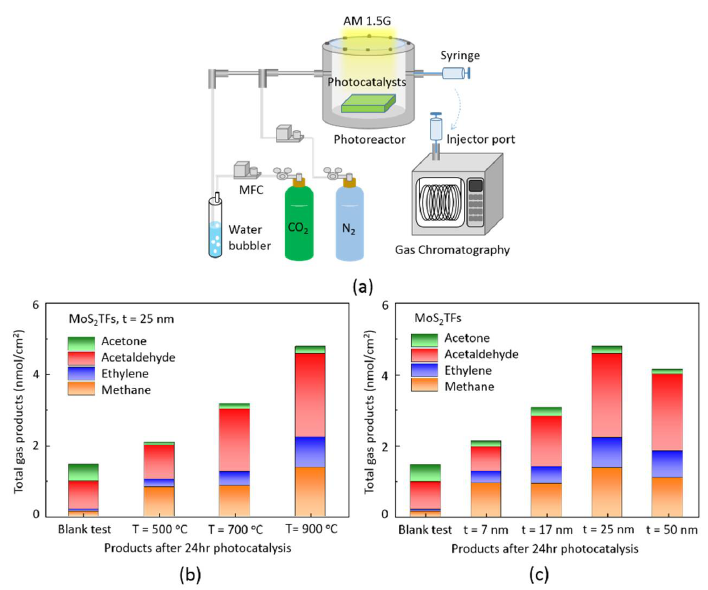
Figure 9. ( a ) Setup of gas-phase PC-CO 2 RR system. The figures below that display the PC-CO 2 RR activity of MoS 2 TFs on sapphire with different ( b ) reaction temperatures and ( c ) different